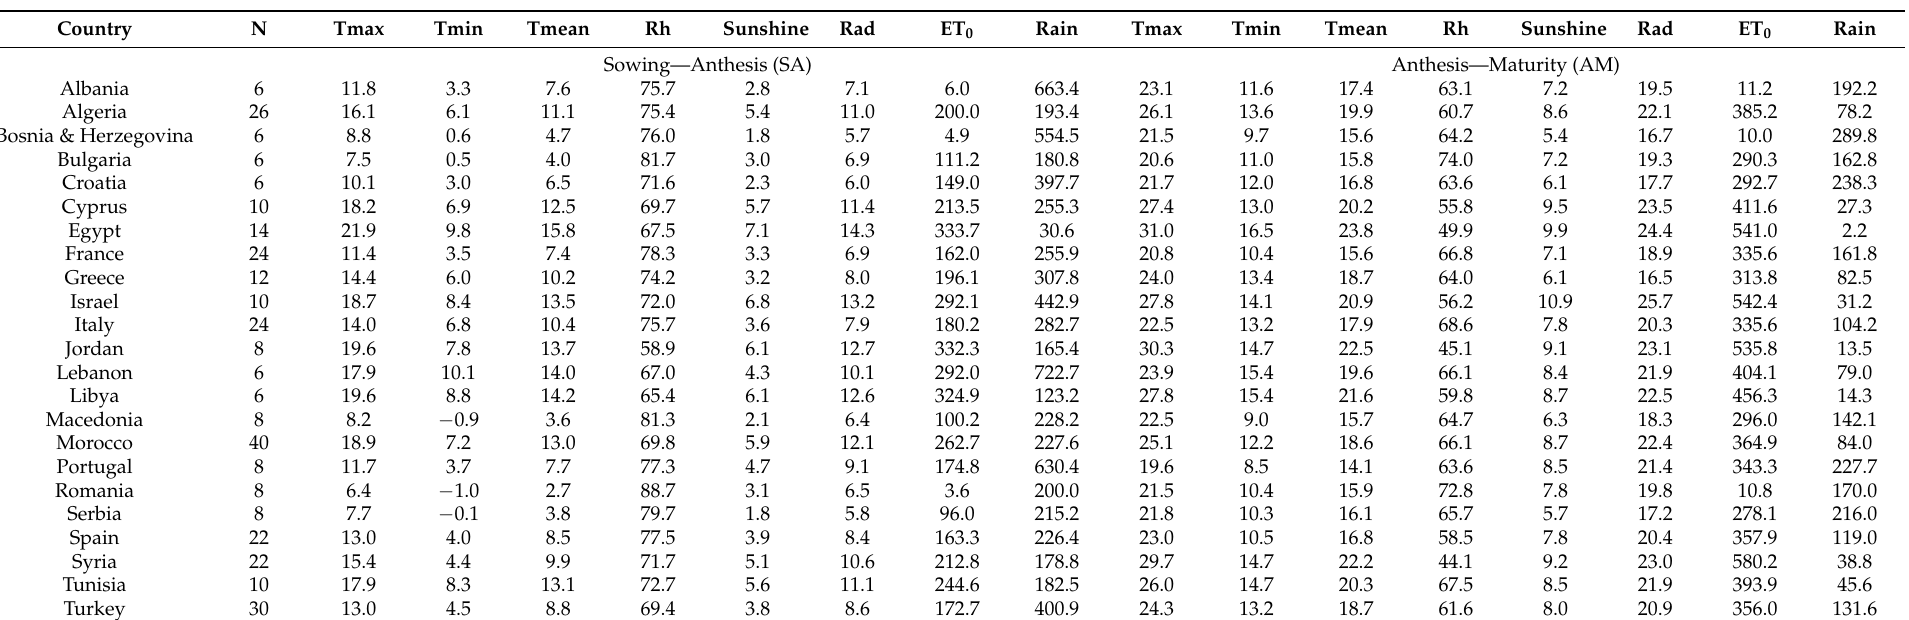
Table 1. Mean of the climatic data of a 15-year period (2006–2021) in the countries of origin of the Mediterranean landraces.